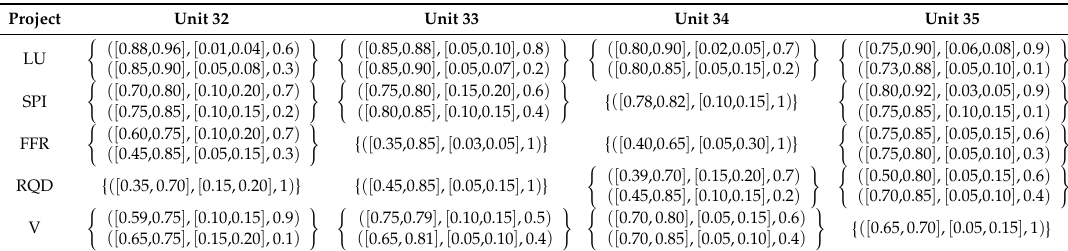
Table 5. D number integral form evaluation matrix.